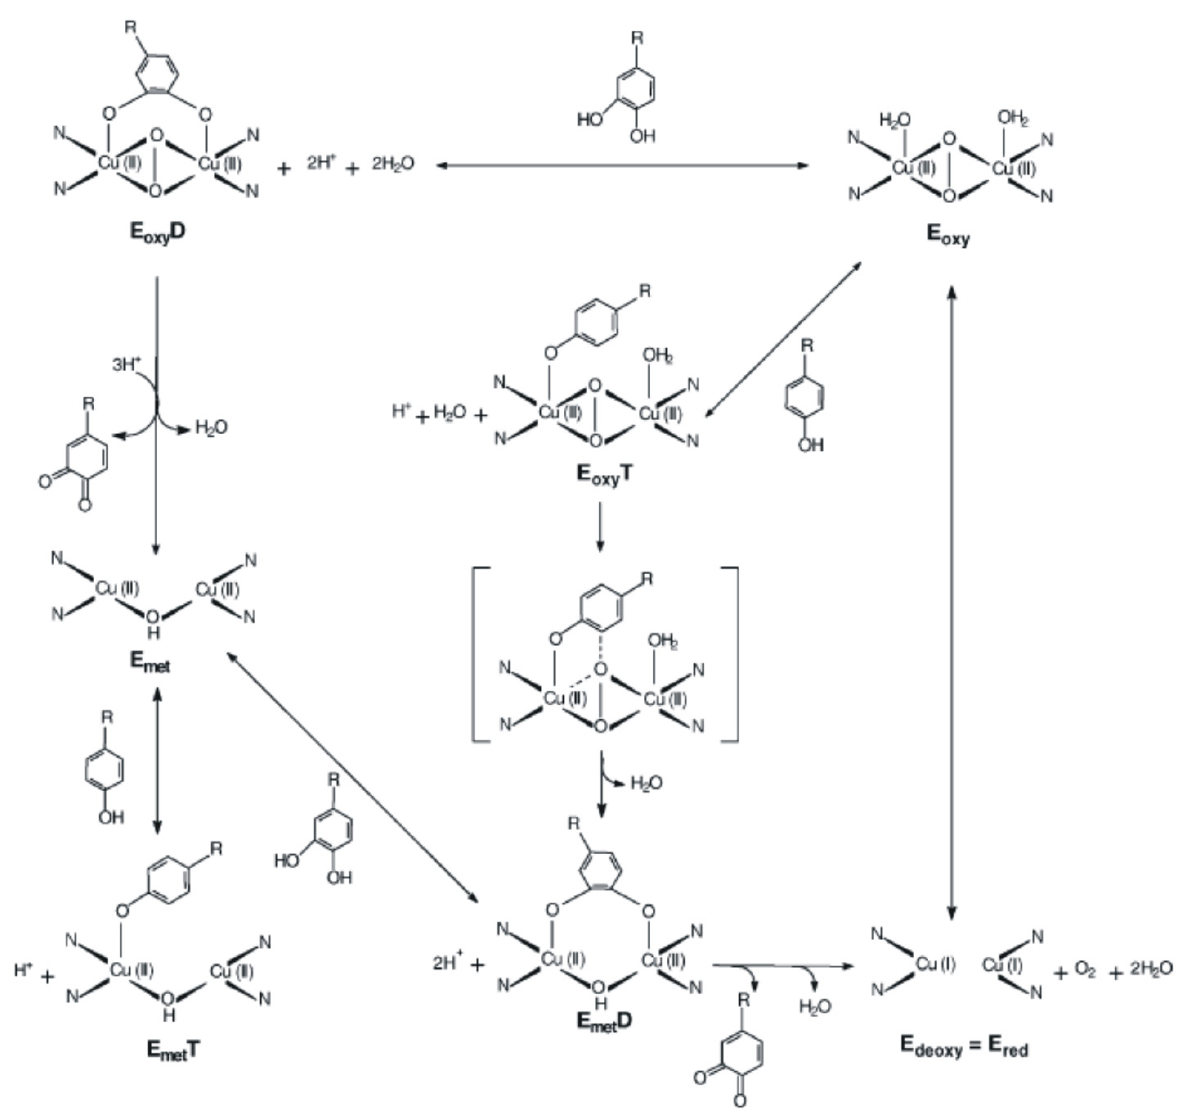
Figure 5. The catalytic cycle for the oxidation of monophenols and diphenols to o-quinone derivatives by tyrosine in the presence of oxygen Reprinted from [110,111] with permission of publisher.